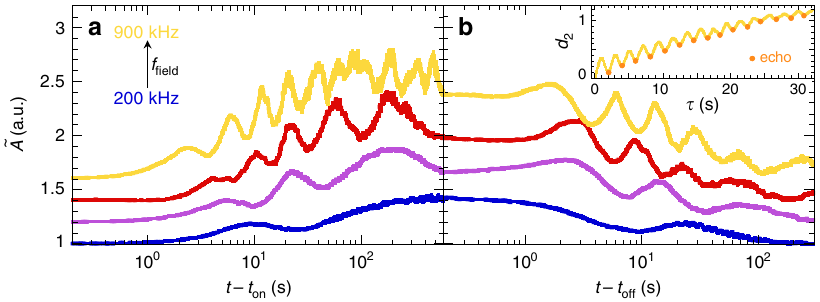
Fig. 3 Kinetics of surface deformations. Change in surface area upon switching the fi eld on ( a ) and off ( b ), measured by the normalized change in scattering intensity, for fi eld frequencies of 200, 300, 500 and 900 kHz. After an initial transient, the surface gradually expands ( a ) resp. contracts ( b ), exhibiting elastic ringing. Both the undulation frequency and fi nal deformation amplitude increase with increasing fi eld frequency. For clarity, the curves are offset vertically by multiples of 0.2. Inset: intensity structure function d 2 versus lag time τ . In line with elastic recoil, d 2 displays clear echoes (orange bullets), implying that the surface recurrently falls back to an earlier position. t − t on = 100 s is chosen as reference